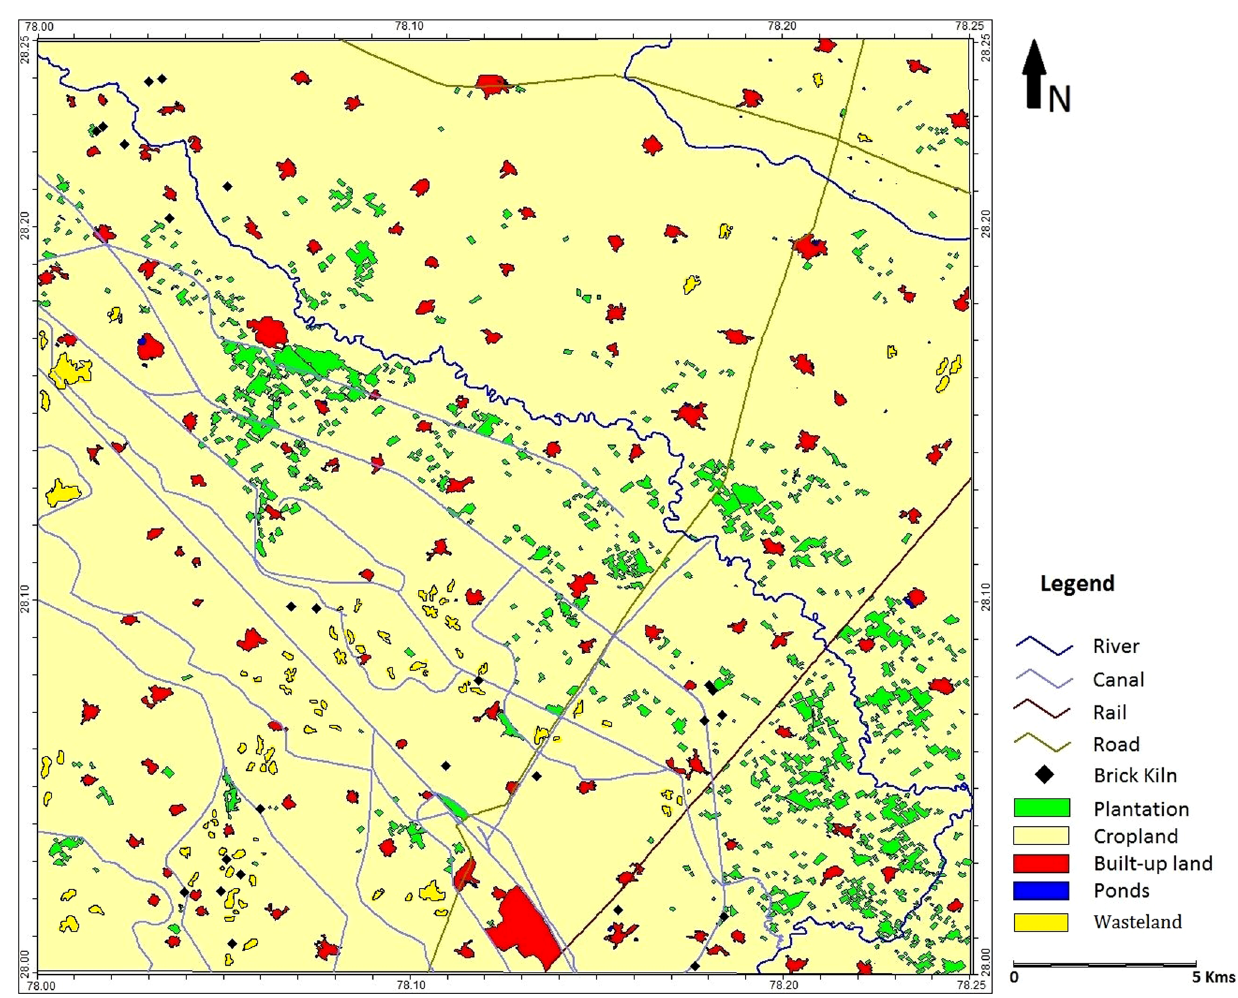
Fig. 6 Land-use map of the study area using google earth imagery 2012 Table 3 GQI statistics for each land-use class Land